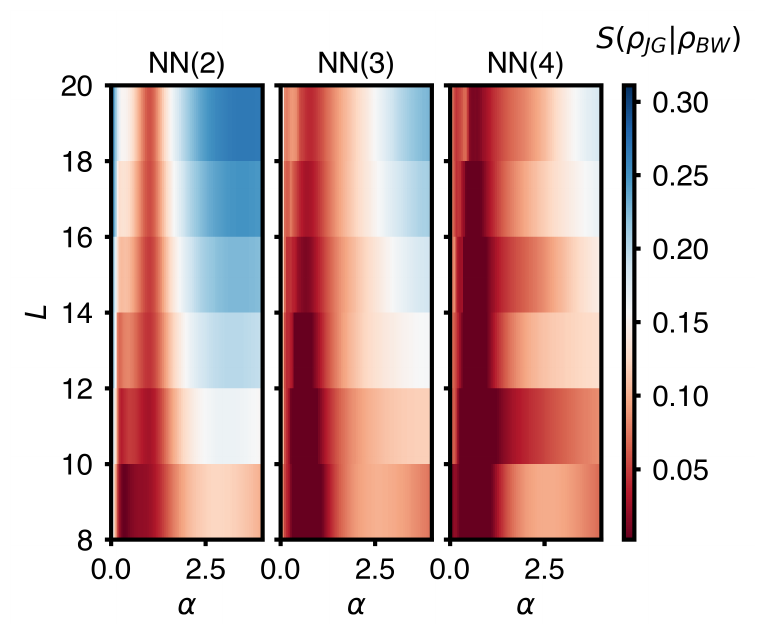
Figure 7: Relative entropy of the JG reduced density matrix and the BW converged one. We see that enlarging the domain of the operator involved, the quality of the results increases. The line α = 1 corresponds to a free fermions